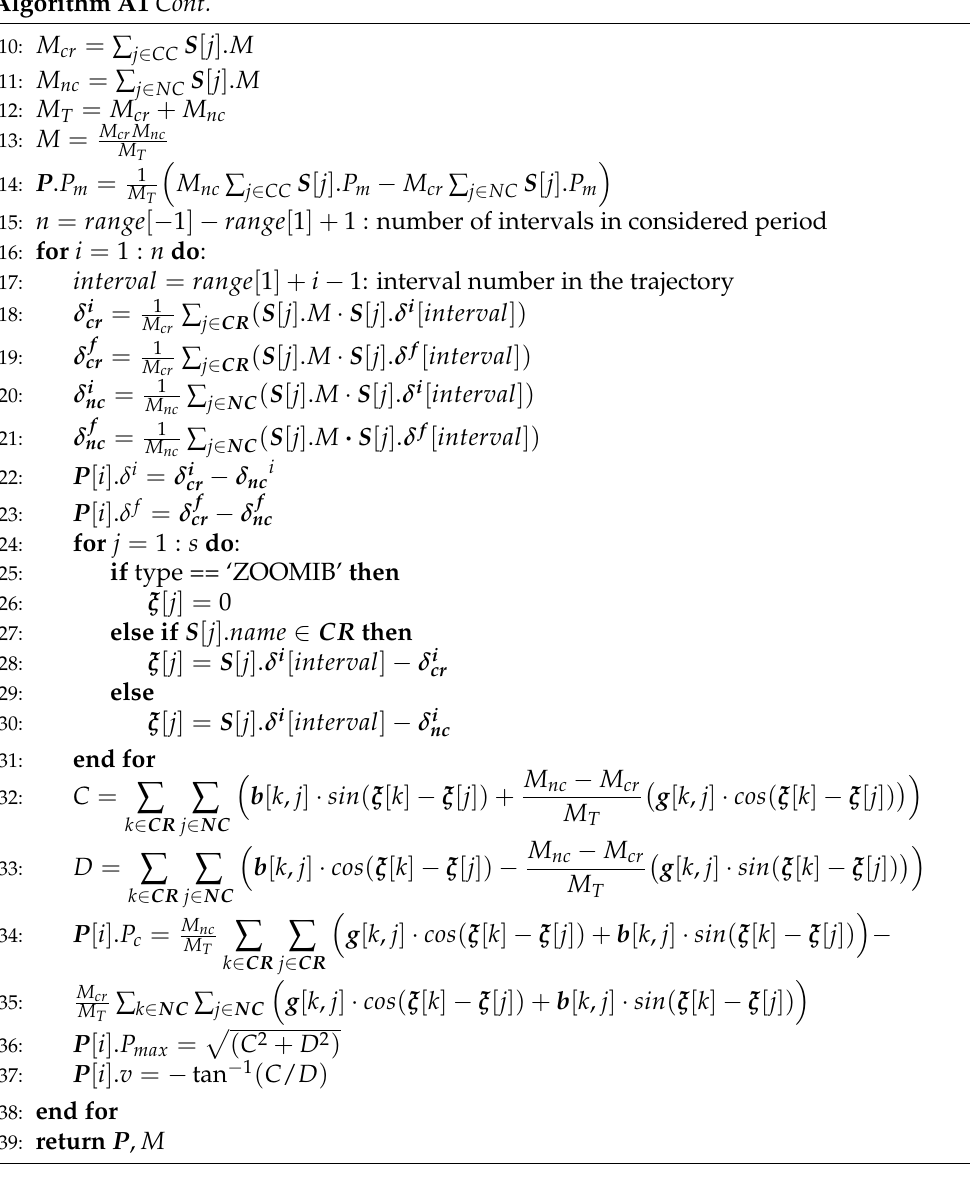
Algorithm A2 pseudocode details the function to compute the CCA of an